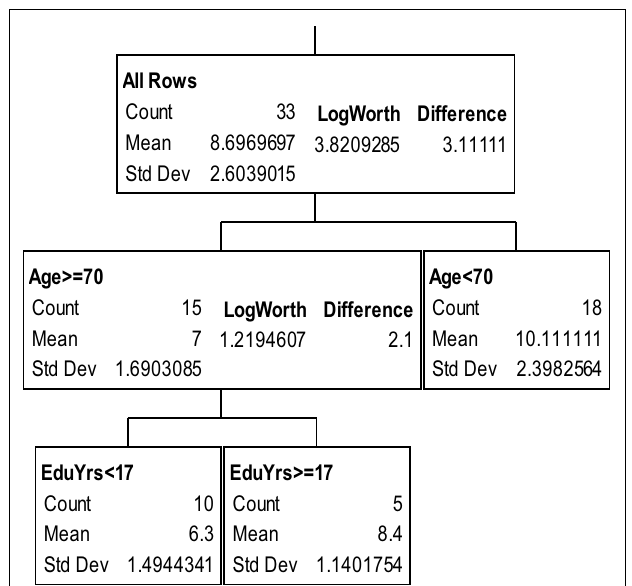
FIGURE 3 | Partition analysis for grooved pegboard dominant hand scaled scores.